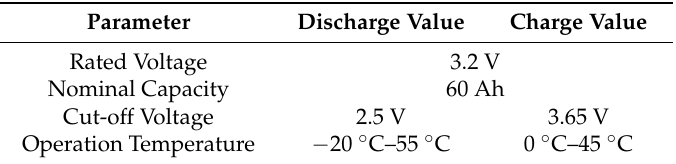
Table 1. Main parameters of